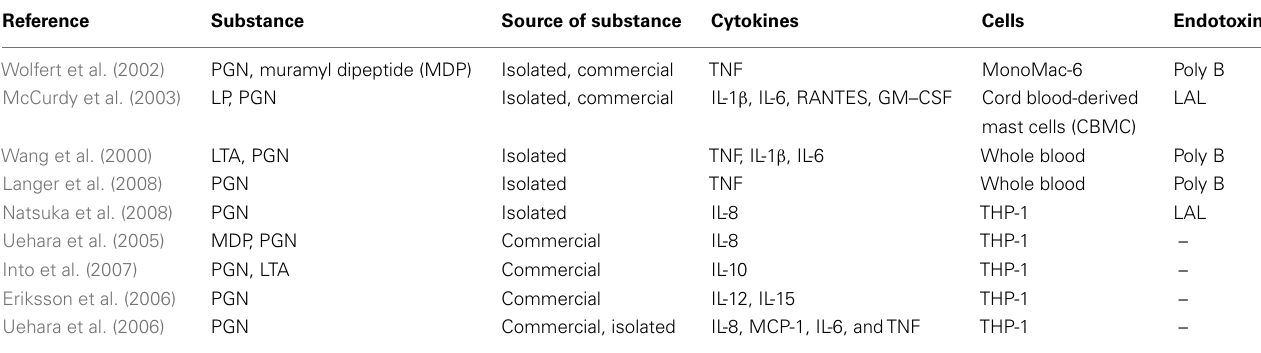
Table 5 | Publications after fulfillment of decision tree for K/D criterion 3 for